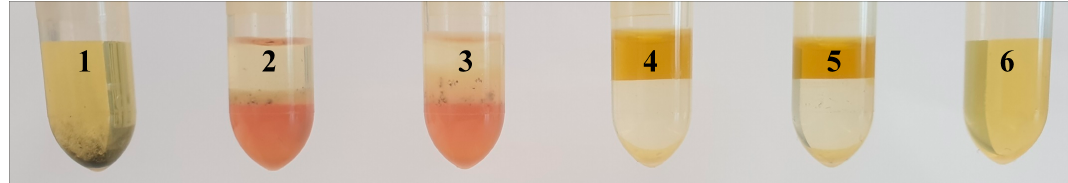
Figure 6. Comparison of QC samples extracted according to Folch (2 and 3) with QC samples extracted using ethyl acetate (EtOAc) (“green” Folch, 4 and 5) with regard to their starch content after centrifugation and filtration (starch detection with Lugol´s solution containing potassium iodide and iodine); 1: positive control sample, 6: negative control sample.